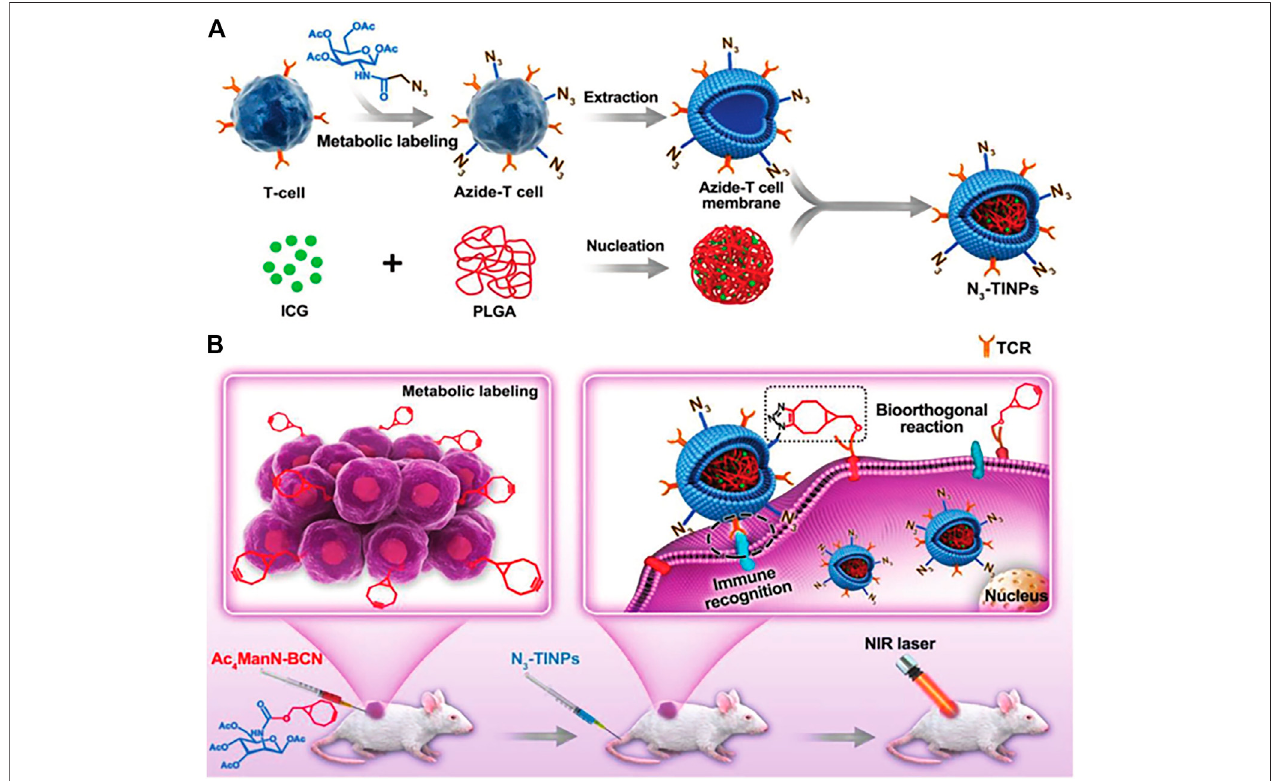
FIGURE 4 | Schematic of N 3 -labeled T cell-encapsulated nanoparticles (N 3 -TINPs) with a dual-targeting mechanism for highly ef fi cient photothermal therapy. (A) Preparation of N 3 -TINPs. (B) N 3 -TINPs could target tumors for phototherapy through immune recognition of T cell membranes and bio-orthogonal responses of BCN and N 3 groups. (Reproduced with permission from Han et al.